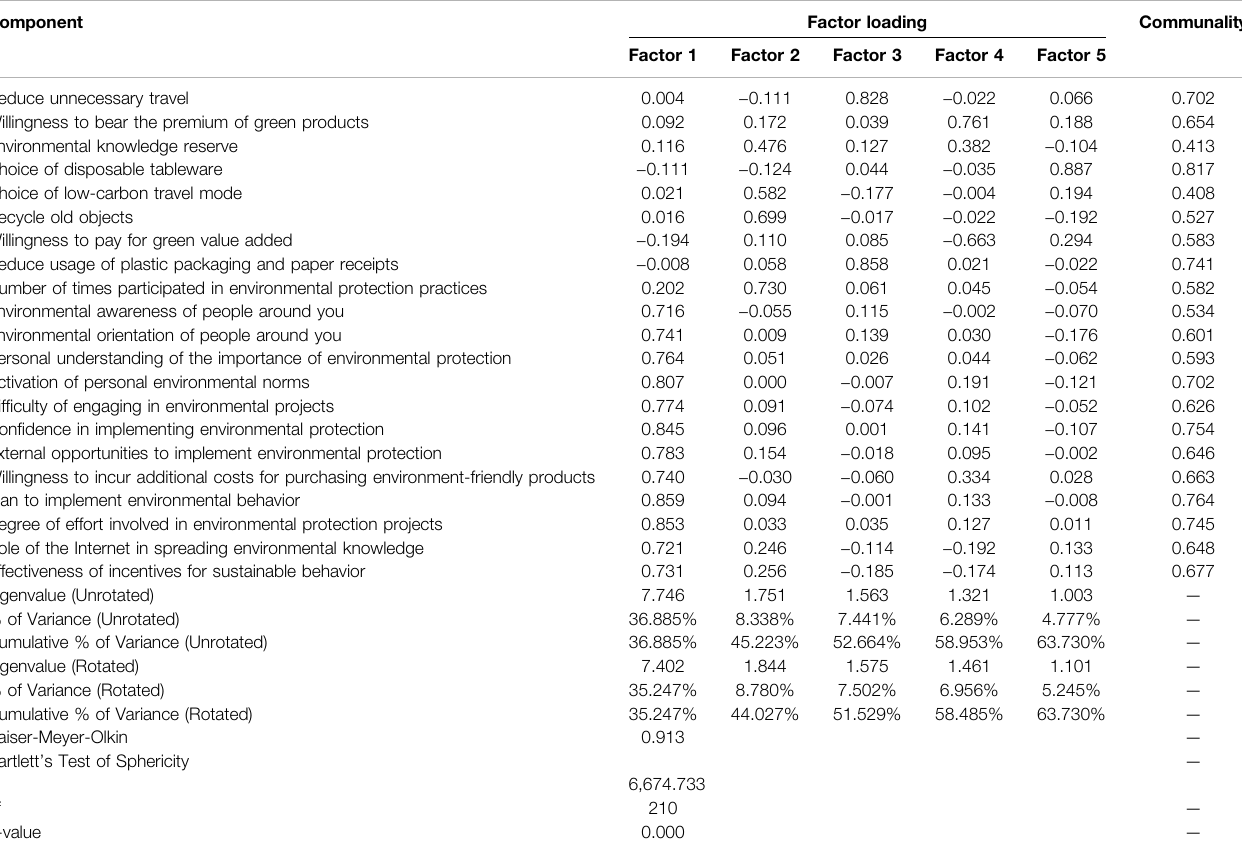
TABLE 3 | Final validity test.